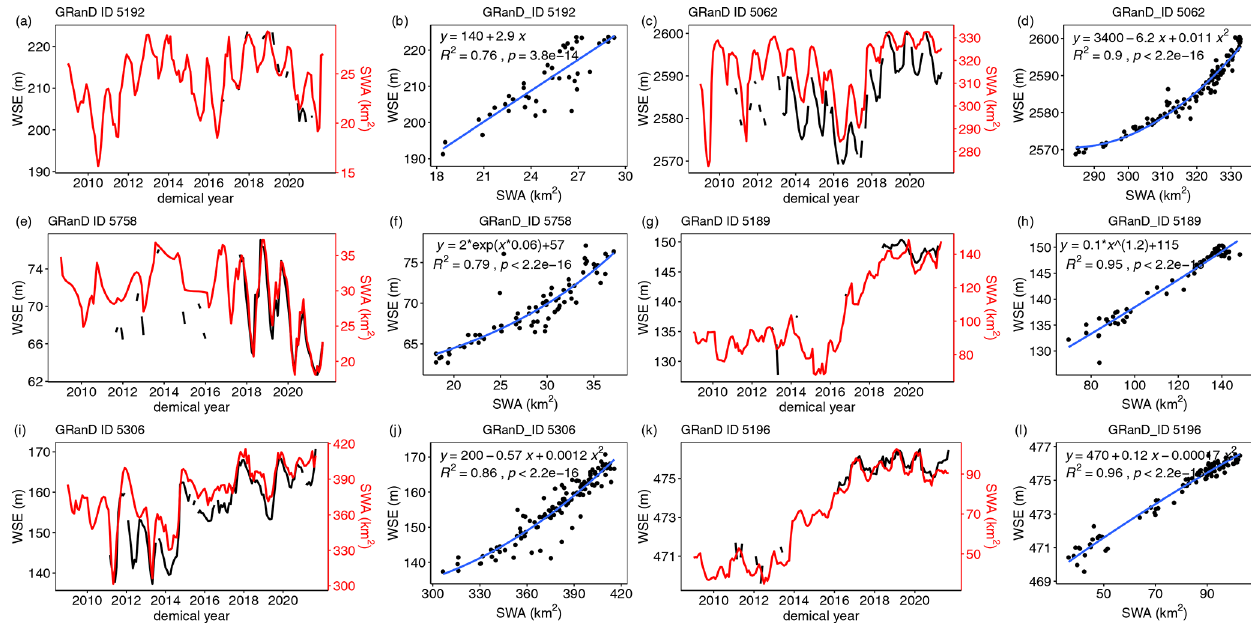
Figure 8. Illustration of A–E relationships constructed by satellite WSE and SWA and their associated time series at six reservoirs. Pan- els (a) – (k) are the Panjiakou, Longyangxia, Baipenzhu, Miyun, Danjiangkou, and Guanting reservoirs, respectively. Note that the time series of WSE and SWA and associated established A–E relationships of the remaining reservoirs are available in our